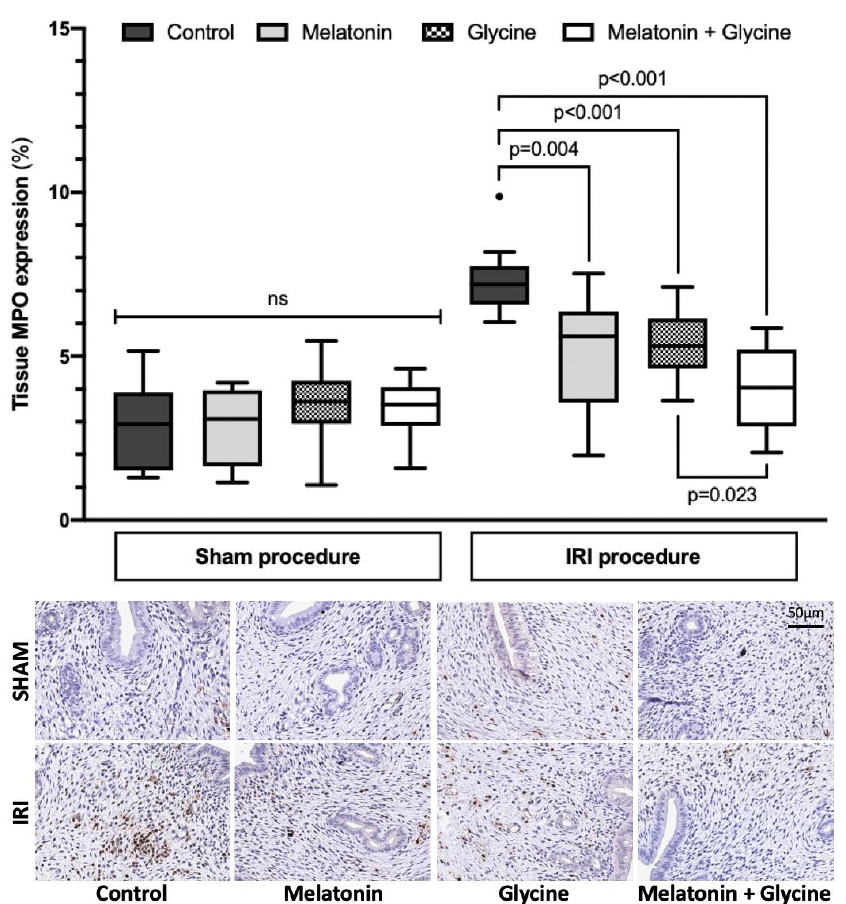
Figure 3. Myeloperoxidase expression in uterus tissue. IRI: ischemia/reperfusion injury. MPO: myeloperoxidase. Data presented as median and interquartile range ( n = 10/group, except n = 9 in sham combined treatment group).